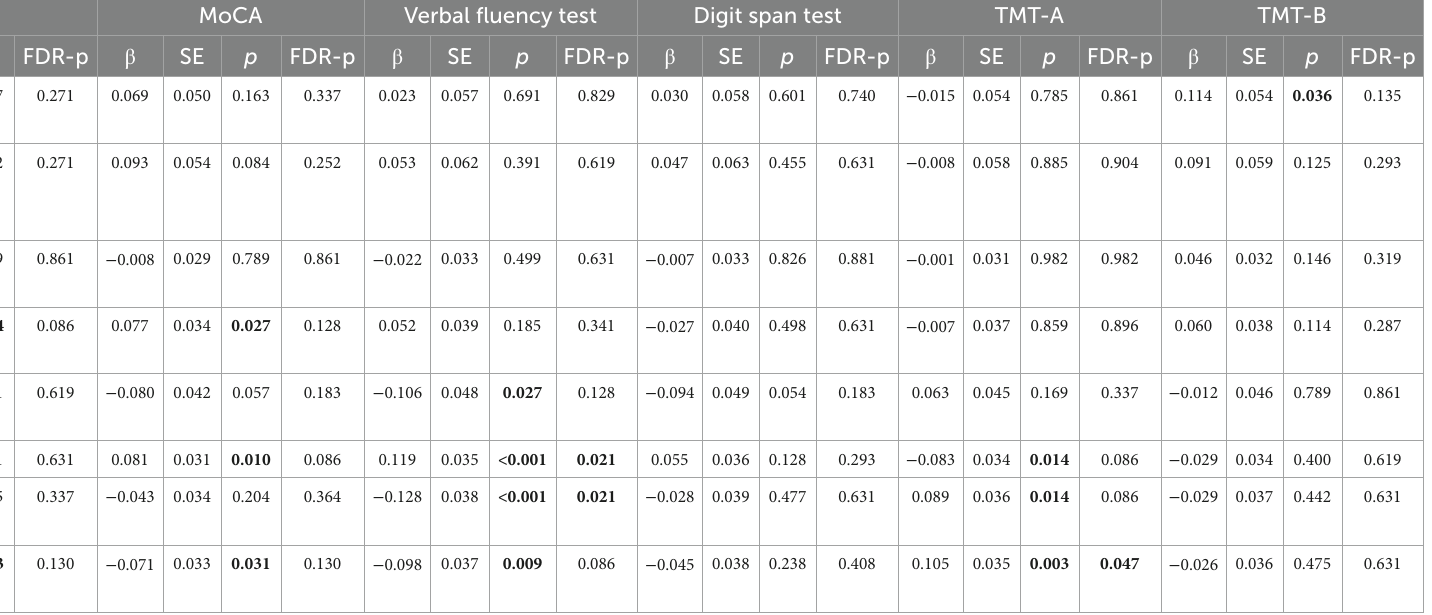
TABLE 2 Association of cortical gray matter, hippocampus, and white matter measures with cognition. MMSE MoCA Verbal fluency test Digit span test